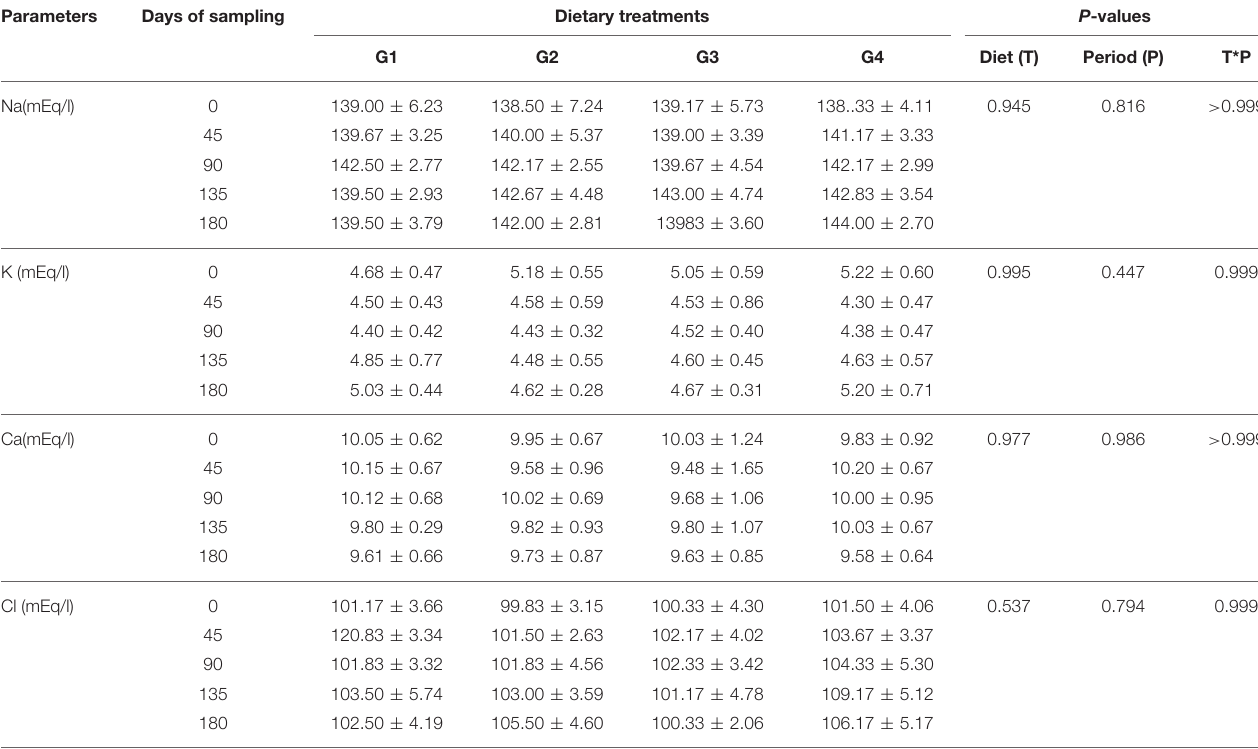
TABLE 5 | Effect of dietary Bt and CP4EPSPS proteins on the Serum electrolyte of male rabbits.